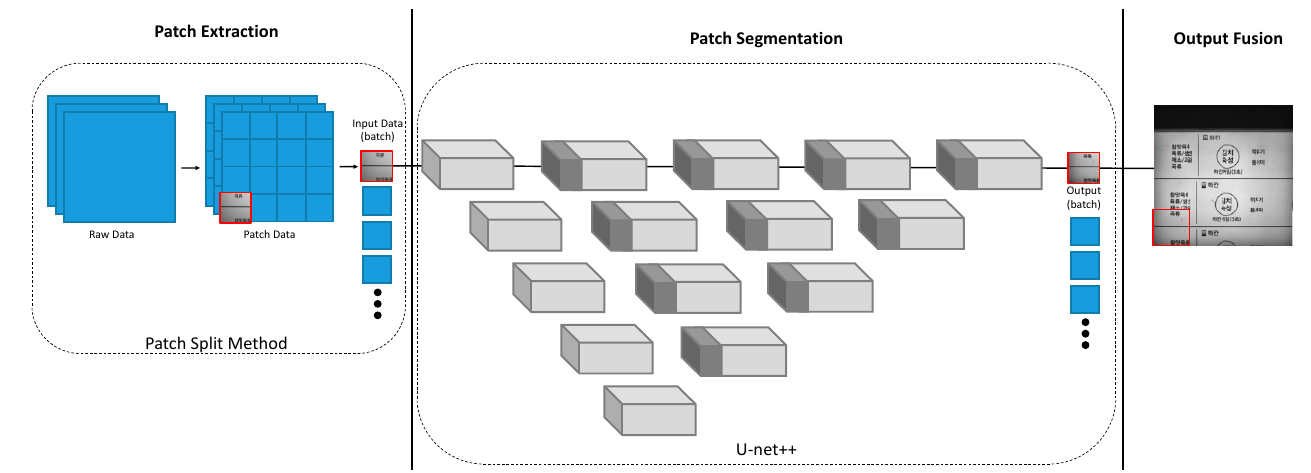
Figure 6. Architecture of the proposed system.